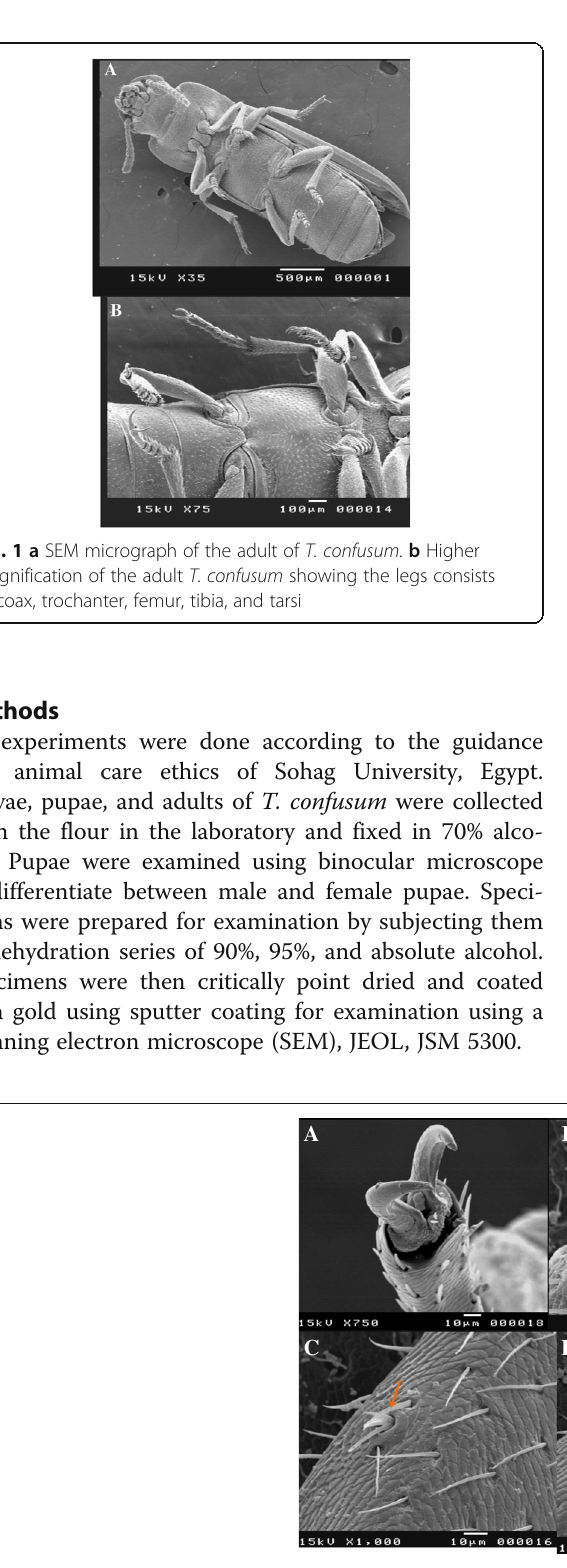
Fig. 2 a Higher magnification of the legs of T. confusum showing two claws which are simple, curved apically, and are equipped with sensillae unequally distributed. b – d Higher magnification of the legs of the male of T. confusum showing the setiferous patch found on the ventral surface of the fore, hind, and middle femur, respectively ( arrows